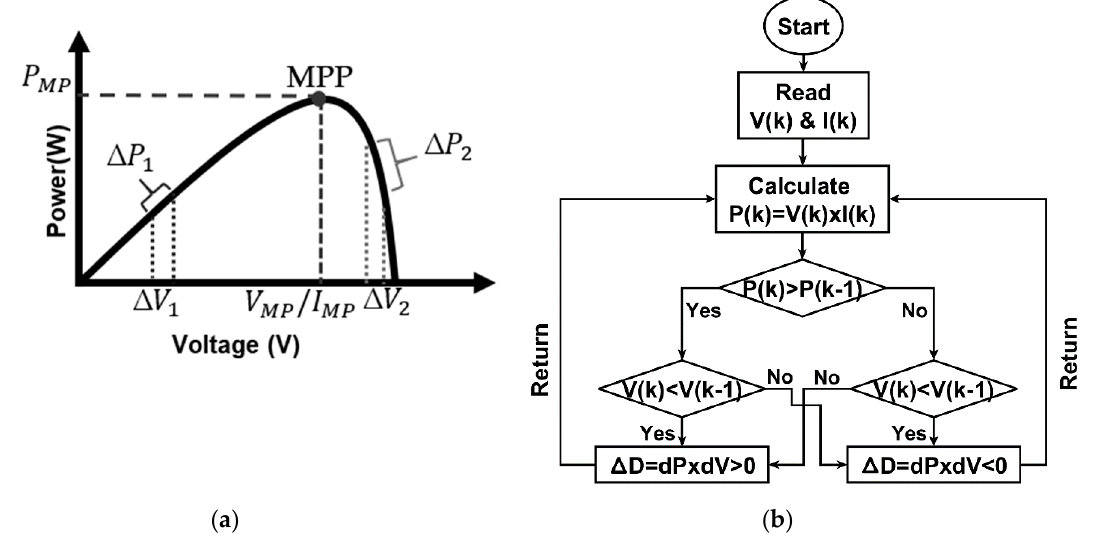
Figure 2. ( a ) P–V curve of a solar PV array on P&O ( b ) proposed flowchart of P&O